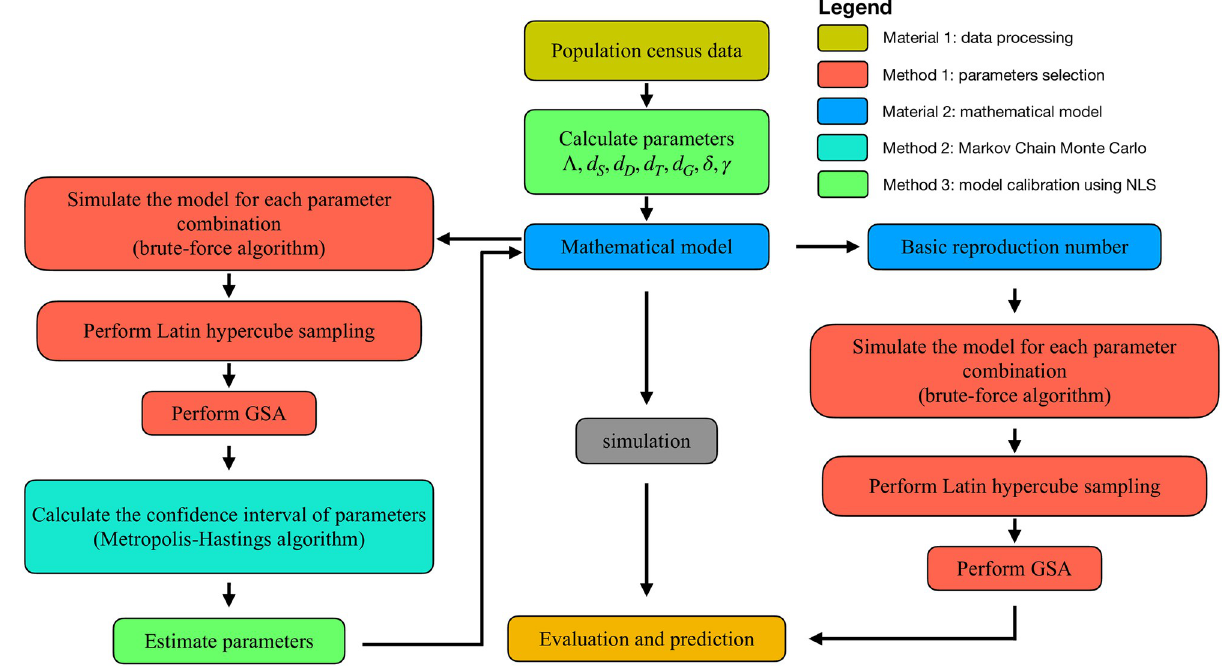
Fig 2. Computational framework. In the first step, we apply nonlinear least square method to estimate parameters ( Λ , d S , d D , d T , d G , δ , γ ( t )) by surveillance data. Next, with the surveillance data, the probability density function (PDF) of parameters ( d Markov-Chain Monte-Carlo (MCMC) method. Then the model parameters are estimated by nonlinear least square method. In the second step, we calculate the reproduction number. In the last step, we try to assess the HIV/AIDS epidemic in Guangxi Zhuang Autonomous Region by calibrating mathematical model and the reproduction number. GSA: Global sensitivity